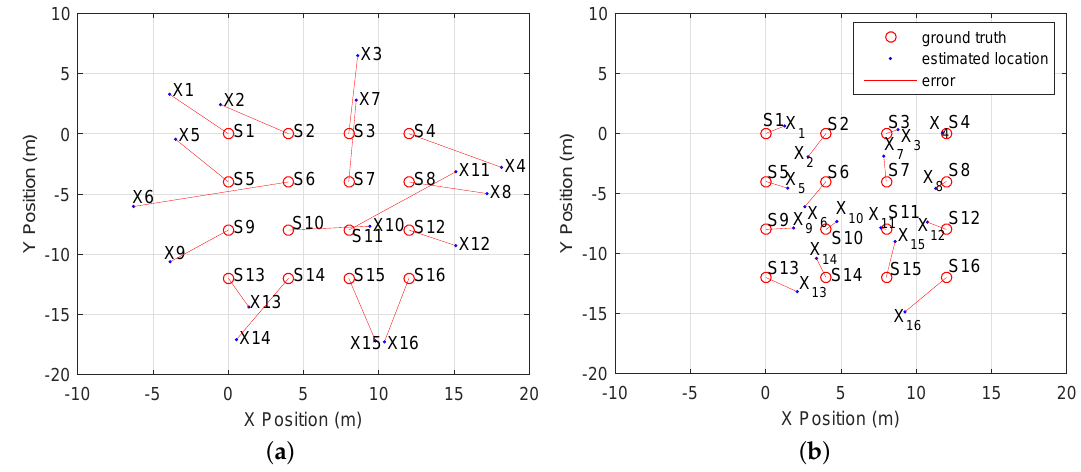
Figure 14. Comparison of ellipsoid [10] and CLASS localization results utilizing our real measurement data. ( a ) Ellipsoid localization results. The RMSE is 6.09 m. ( b ) CLASS localization results. The RMSE is 1.97